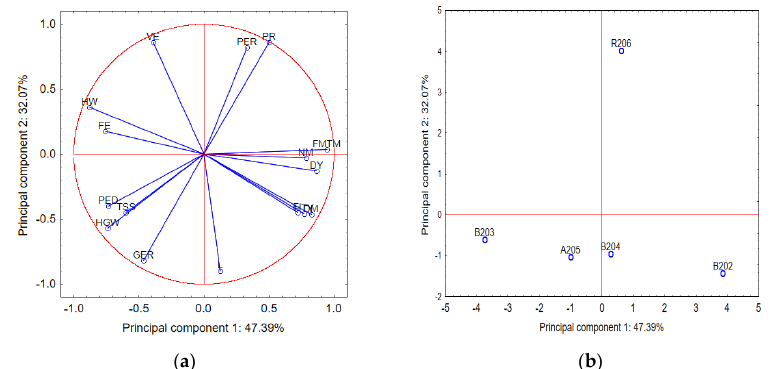
Figure 2. Principal component analysis (PCA) plots of native maize from the Jalisco Highlands, Mexico. ( a ) Location of different physicochemical quality parameters; ( b ) Location of different maize cultivars. Table 6. Factor coordinates of the physicochemical parameters, based on correlations.